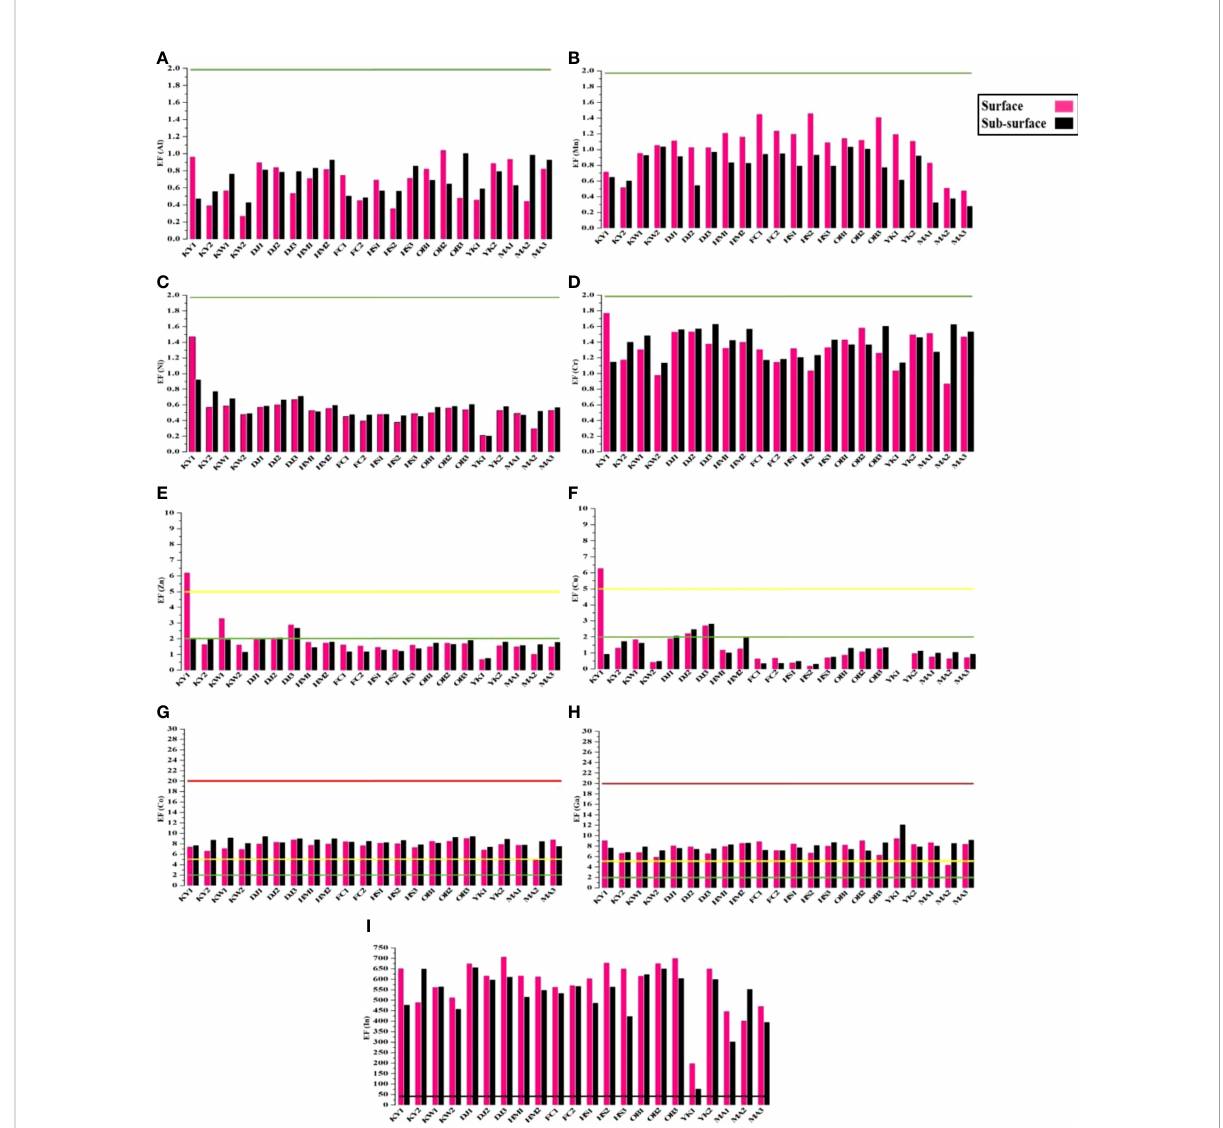
FIGURE 4 The values of Enrichment factor (EF) with pollution degree for studied metals in surface and sub-surface sediments of Siangshan wetland. Green, yellow, red, and black lines refer to classes 0, 1, 2, and 4, respectively (Table